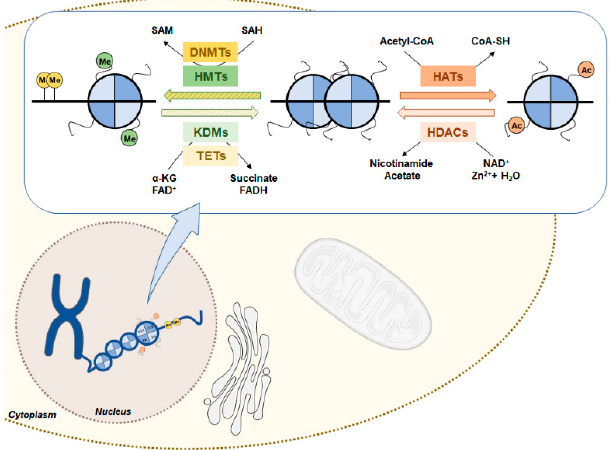
Figure 3. DNA methylation and histone PTM in gene expression regulation. DMNTs catalyze cytosine methylation using SAM as a methyl donor, which is converted to SAH. TETs revert DNA methylation by a hydroxylation α -KG-dependent reaction. Histone methylation patterns are established by HMTs using SAM as methyl donor. Inversely, histone demethylases KDMs remove the methyl group of histone tails using FAD + or α -KG as cofactor. HATs imprint acetylation marks in histone transferring the acetyl group of acetyl-CoA to histone tails. Histone acetylation marks can be removed by HDACs using as co-factor NAD + or Zn 2+ . Abbreviations: CoA-SH, Coenzyme A; DMNT, DNA methyltransferase; HAT, Histone acetyltransferase; HDAC, Histone deacetylase; NAD, Nicotinamide